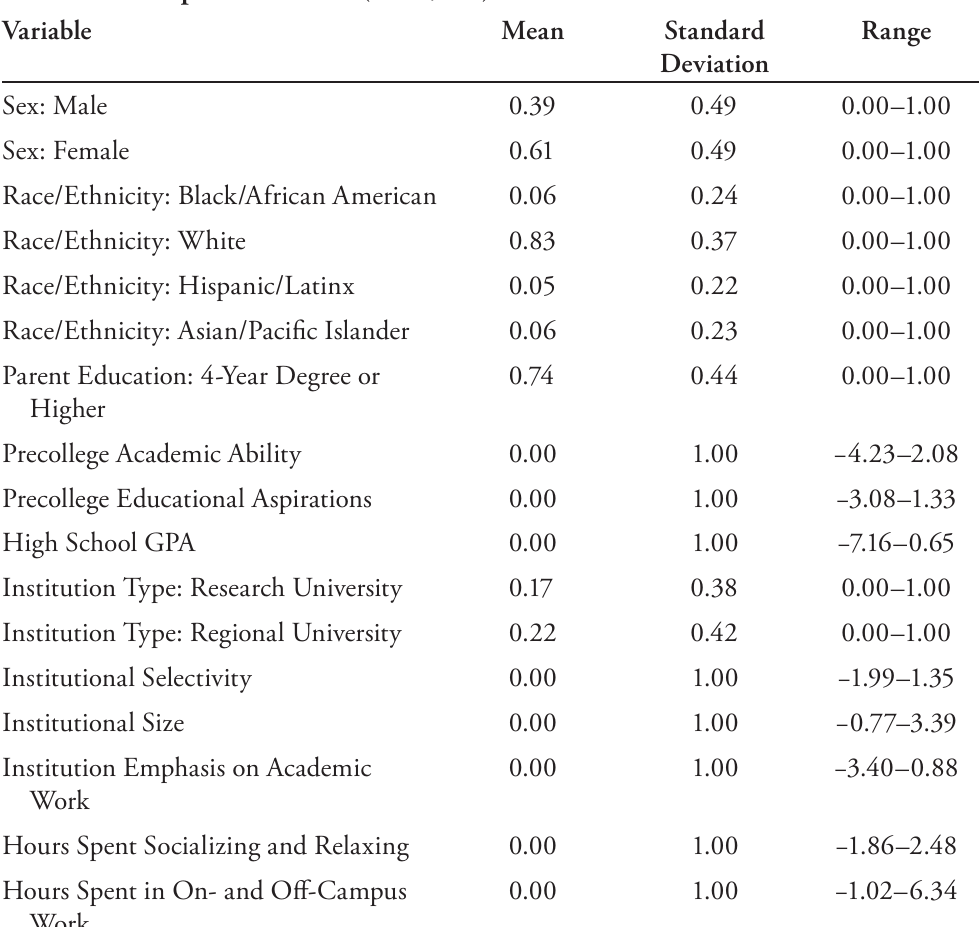
Table 1. Descriptive Statistics (n =